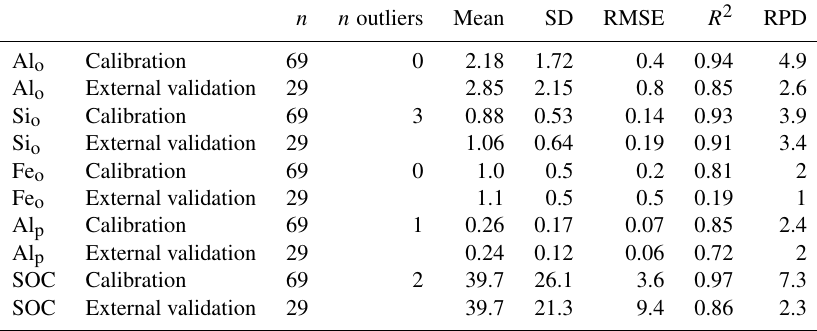
Table 1. Validation statistics of modified partial least-squares (mPLS) regression for the models used to predict SOC and extractable Al, Si, and Fe contents from MIR spectra. n n outliers Mean SD RMSE R 2 Al o